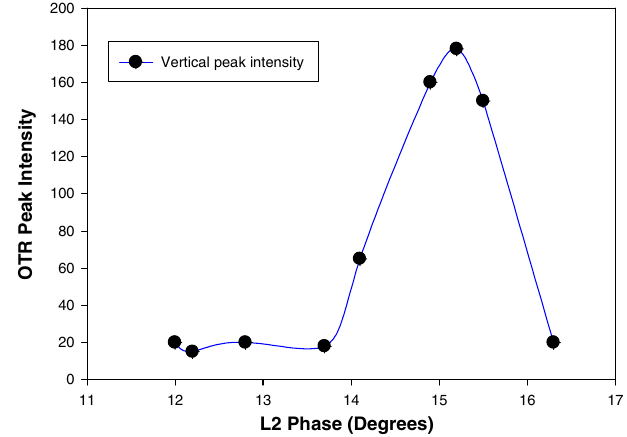
FIG. 6. (Color) Plot of the peak intensities from the OTR image vertical profiles taken near the enhanced regime coordinates as a function of L2 phase in